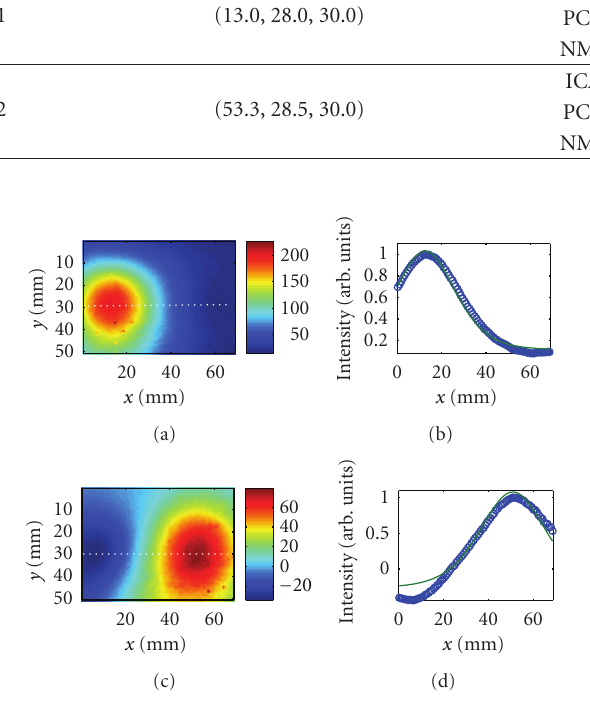
Figure 10: ICA-generated ICIDs on the detector plane are shown in (a) and (c); corresponding Green’s function fits to the horizontal spatial profiles through the dashed line are shown in (b) and (d).